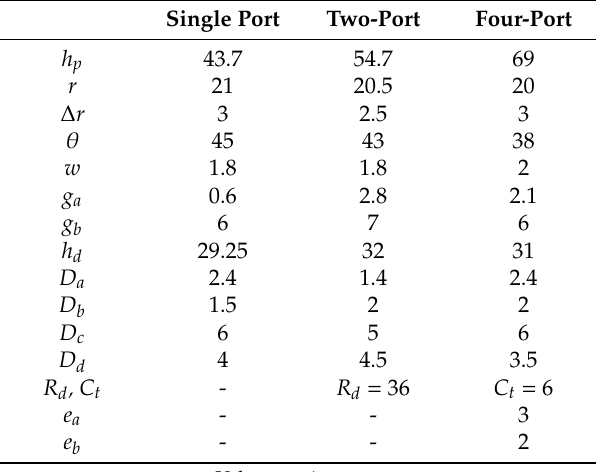
Table 1. Geometrical dimensions for different antennas.